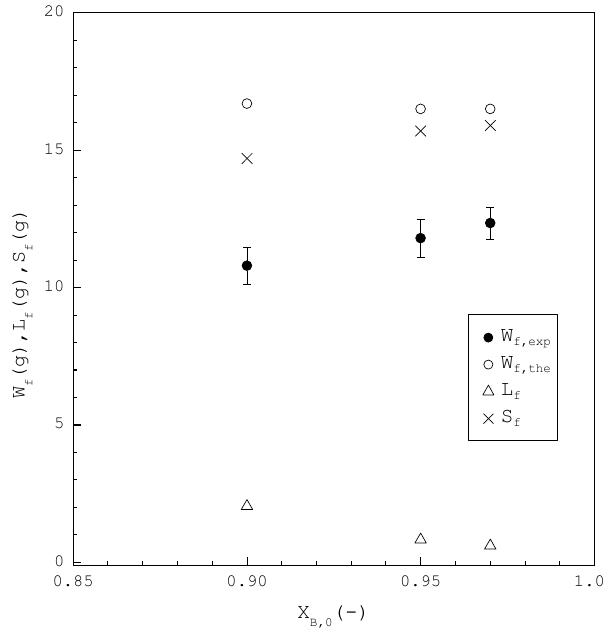
Figure 8. Comparison of L f , S f , W f , the and W f , exp of the final product plotted against X B ,0 for the purification of p -chlorophenol from 20 g liquid feed. Each solid circle data point represents the average W f , exp for four repetitive experiments and error bar represents the 95% confidence interval for the experimental W f , exp .